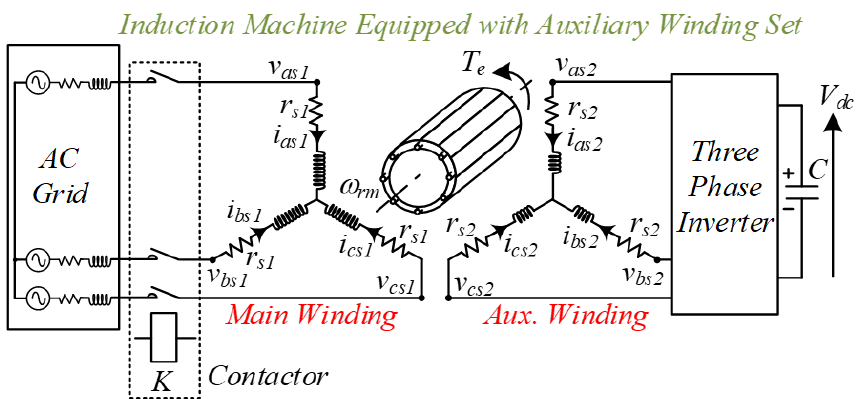
Figure 1. Double-winding induction motor (DWIM) featuring an auxiliary winding set, fed by a three-phase low power, low voltage, Voltage Source Inverter (VSI).